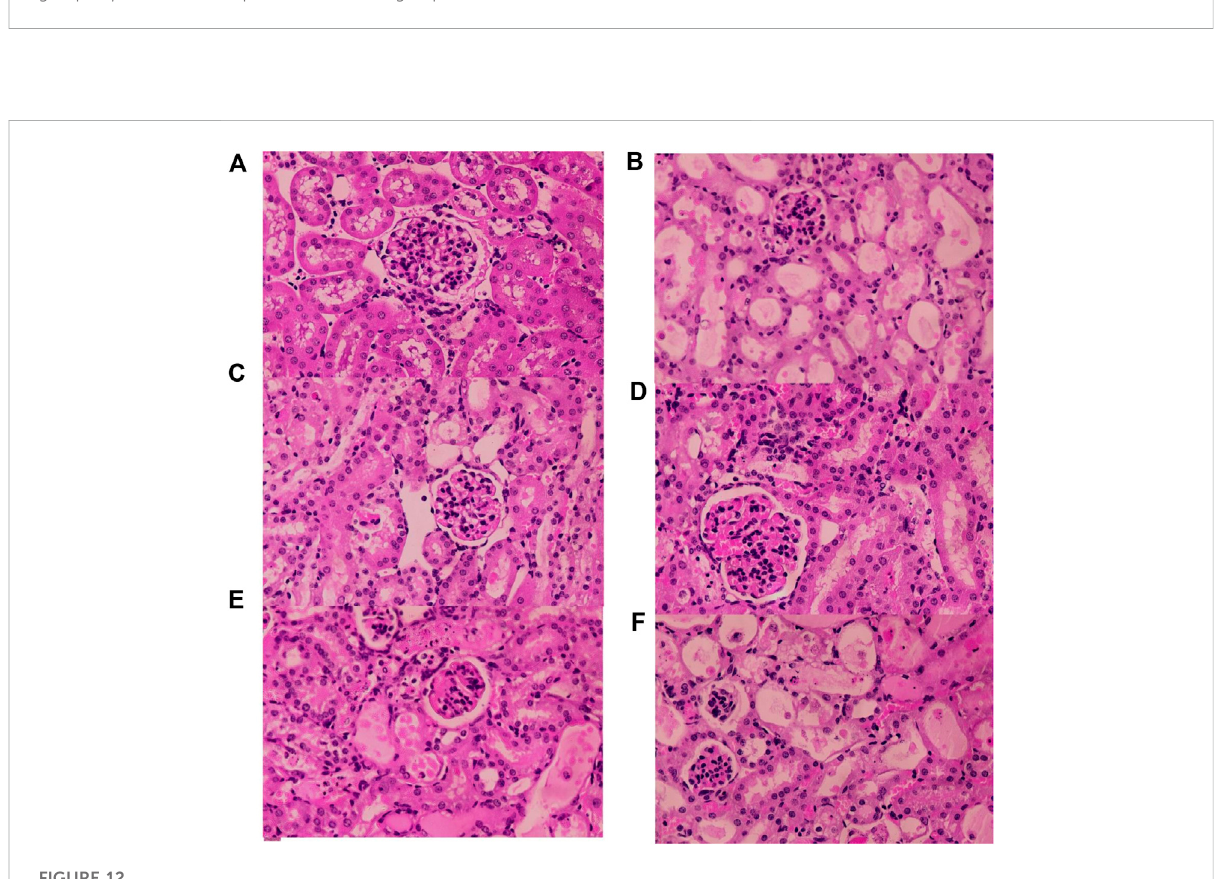
FIGURE 12 Results of histopathological HE staining of the kidneys of various groups of mice (HE × 400). (A) Normal control group (B) Model control group (C) Fer-1 control group (D) RFP high dose group (E) RFP medium-dose group (F) RFP low dose group.